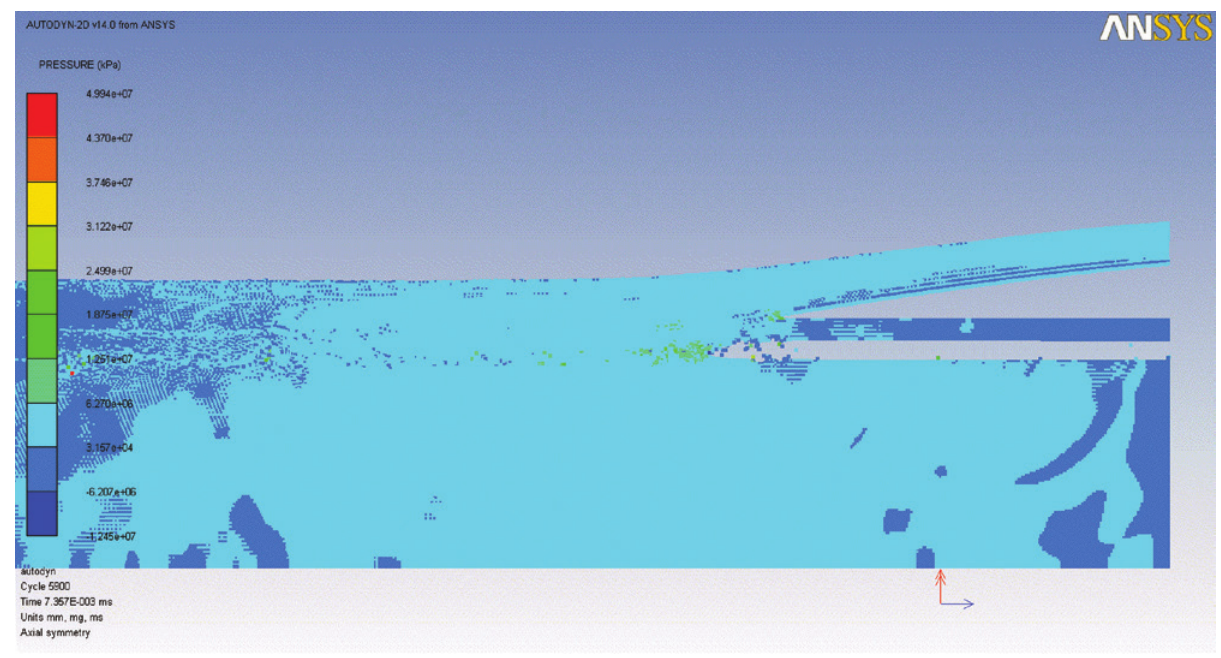
Figure 5: The pressure distribution of combination in the simulation.